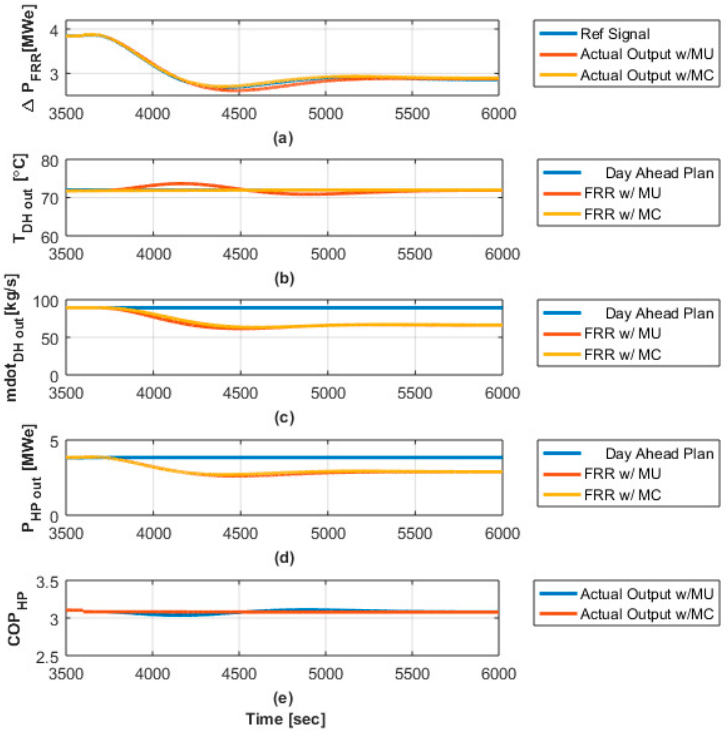
Figure 15. Heat-Pump response to a synthetic aFRR activation signal from TSO control center: ( a ) additional power contribution according to FRR response; ( b ) temperature of forwarded water into DH network; ( c ) hot water’s mass-flow to DH network; ( d ) electrical power consumption of HP and ( e ) HP’s COP.